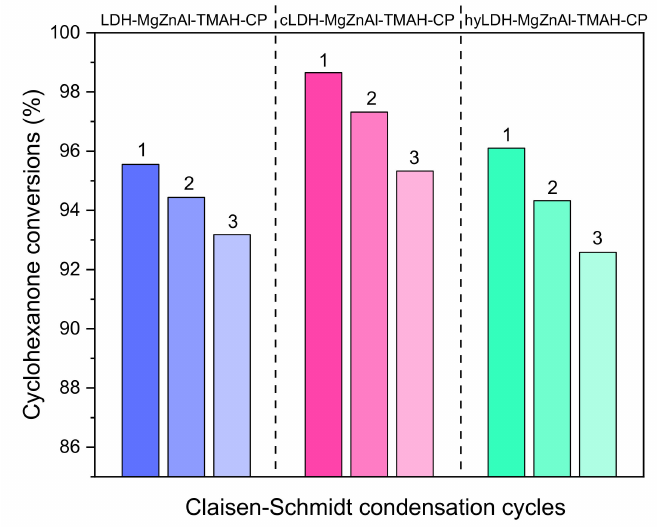
Figure 8. The catalyst reusability after 3 cycles in Claisen-Schmidt Condensation for catalysts prepared by co-precipitation with organic